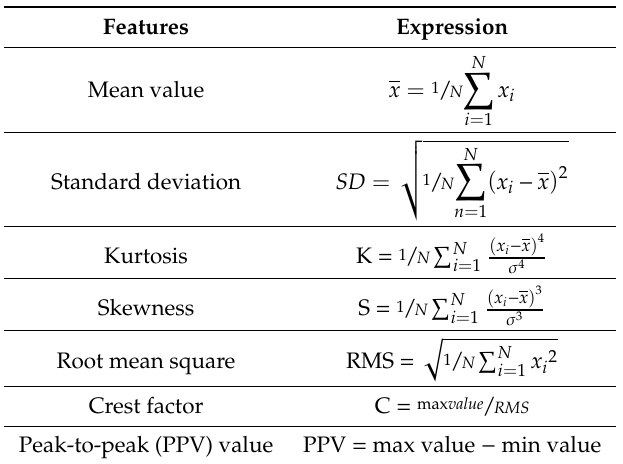
Table 2. Statistical time-domain